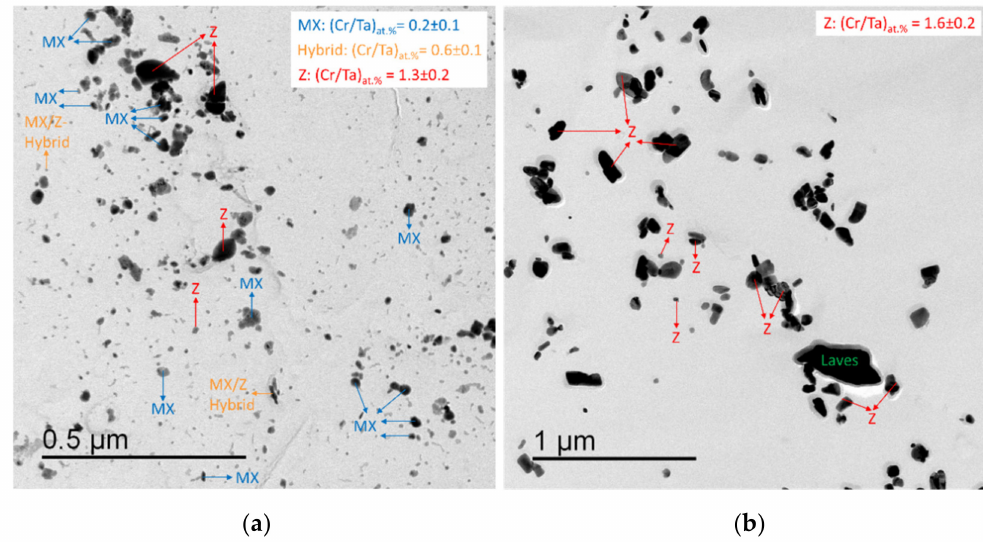
Figure 3. TEM extraction replicas of Z6 in ( a ) condition 1 and ( b ) condition 2.